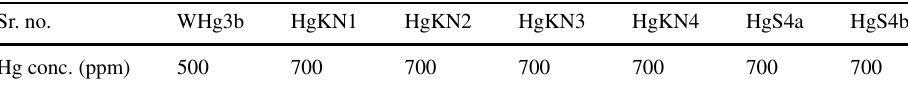
Table 7 Salinity tolerance of the mercury-resistant isolates